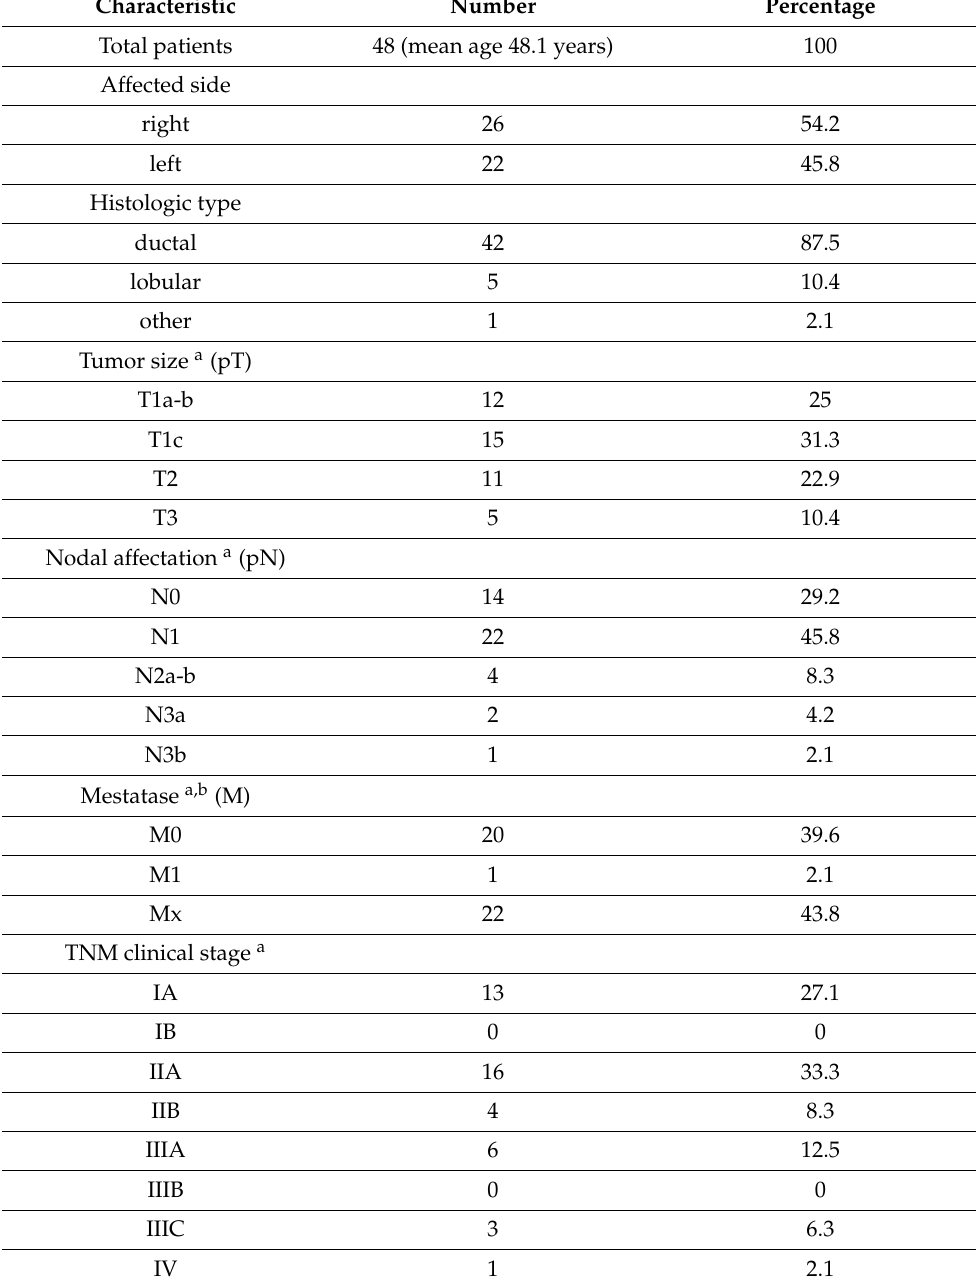
Table 2. Patient demographic information and clinical characteristics at initial